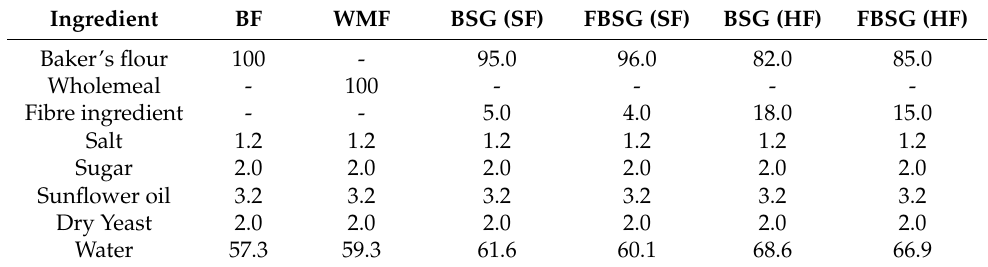
Table 2. Bread recipes expressed as % based on flour + fibre ingredient (=100%). BF and WMF represents Baker’s flour and Wholemeal Flour, respectively. SF and HF represent “source of fibre addition level” and “high in fibre addition level”, respectively. BSG and FBSG denotes “brewers’ spent grain” and “fermented brewers’ spent grain”,